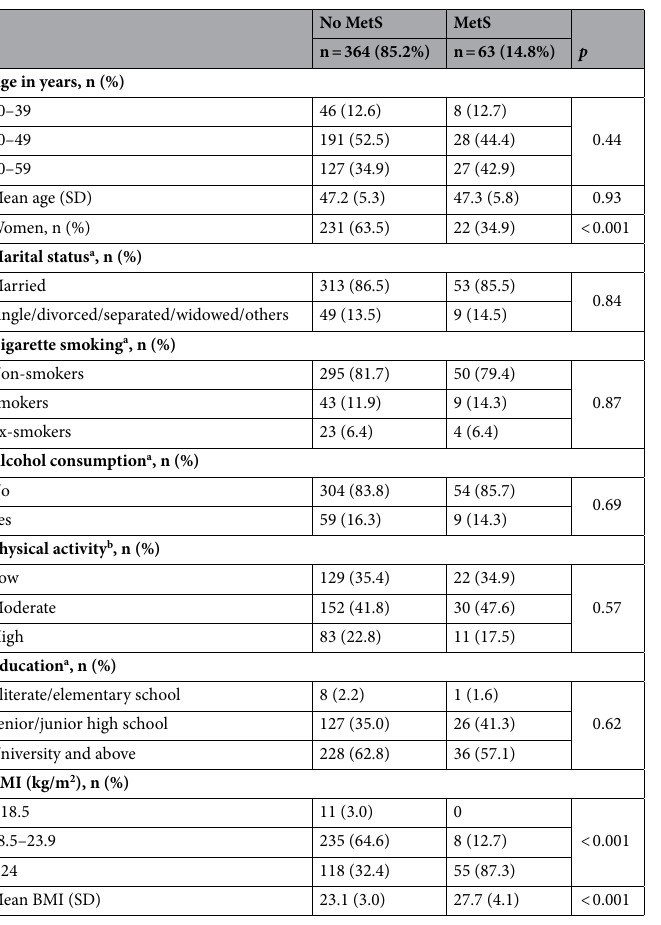
Table 1. Demographic characteristics of the study population at baseline (n = 427). Chi-square tests and Fisher’s exact tests were used for categorical variables. T-tests were used for continuous variables. MetS metabolic syndrome, SD standard deviation, BMI body mass index. a There were few missing data in these covariates. b Physical activity was evaluated by the International Physical Activity Questionnaire (IPAQ) Short- Form, Taiwan